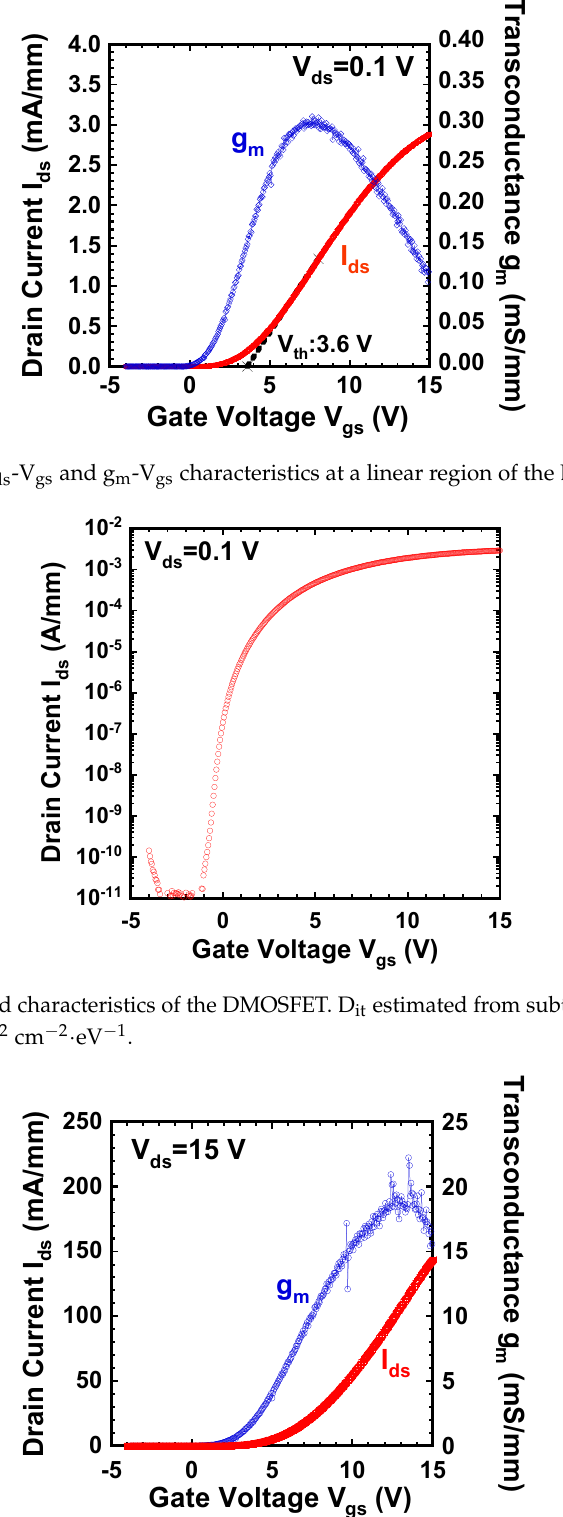
Figure 12. I ds -V gs and g m -V gs characteristics of the DMOSFET at V ds = 15 Figure 12. I ds - V gs and g m - V gs characteristics of the DMOSFET at V ds = 15 V. Figure 12. I ds - V gs and g m - V gs characteristics of the DMOSFET at V ds = 15 V. Figure 12. I ds - V gs and g m - V gs characteristics of the DMOSFET at V ds = 15 V.